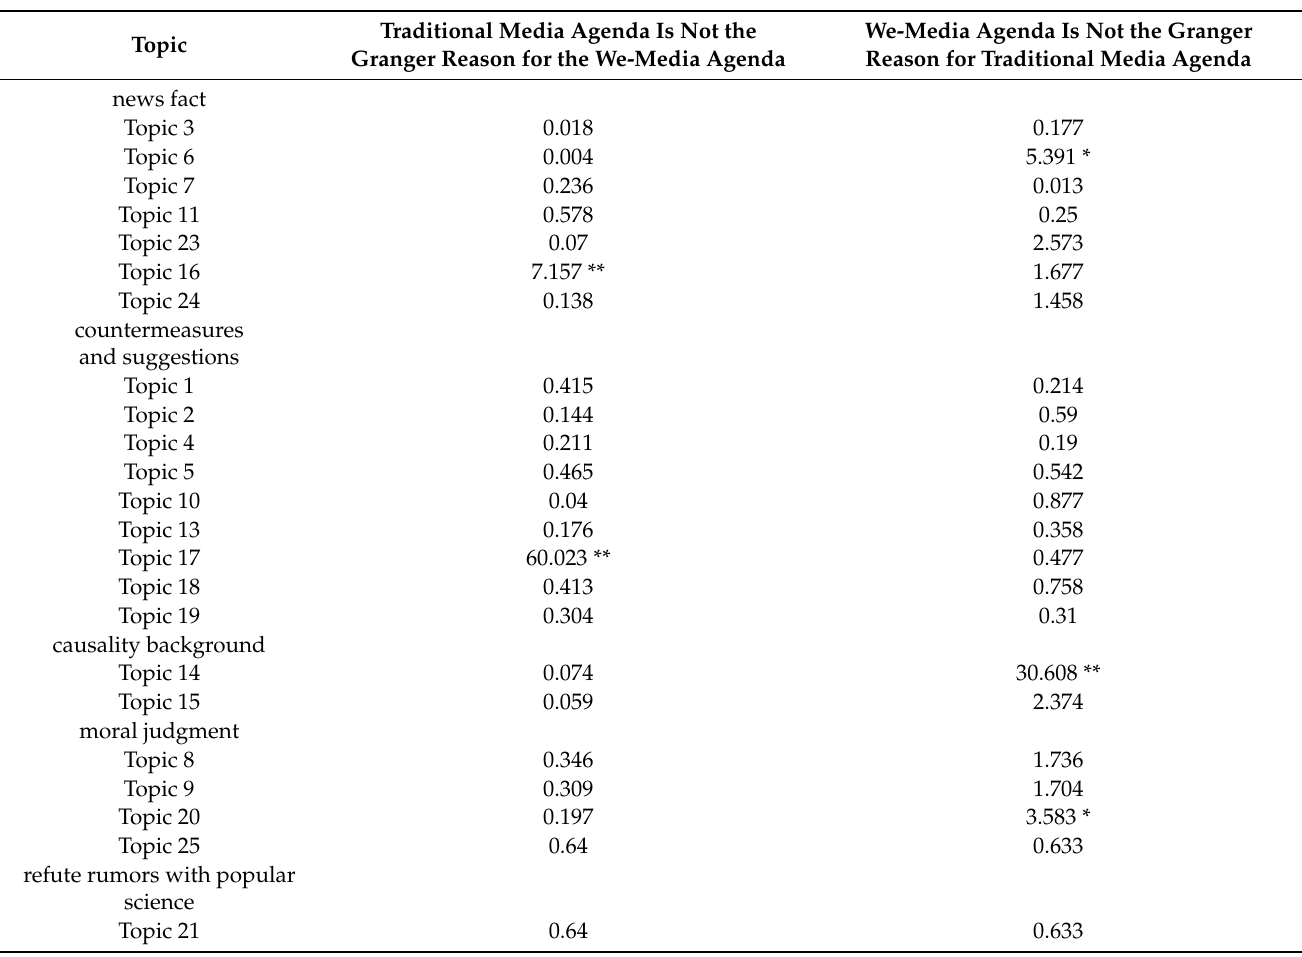
Table 8. Granger Causality